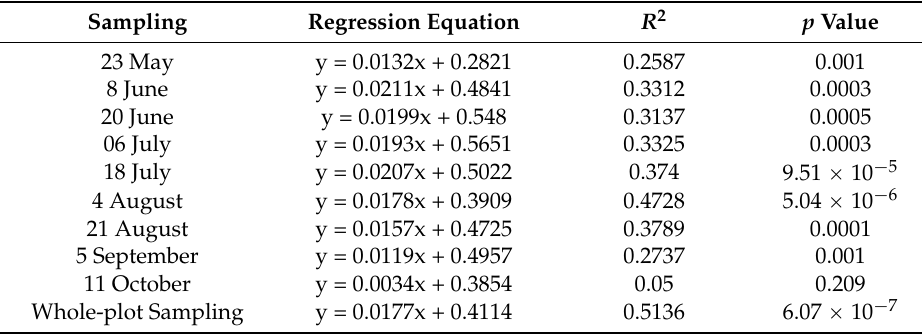
Table 2. Species richness–NDVI relationships for various dates in 2014 compared to the whole plot results obtained at mid-summer (23 July–2 August 2014).